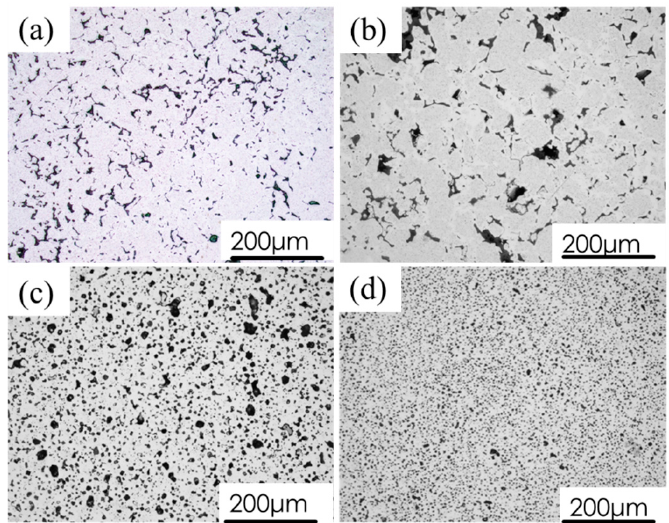
Figure 9. OM micrographs of as-sintered HEA NiMnFeCu. ( a ) At 1000 ◦ C for 1 h (S1), ( b ) at 1000 ◦ C for 2 h (S2), ( c ) at 1050 ◦ C for 1 h (S3), ( d ) at 1050 ◦ C for 2 h (S4). The microstructures of S1–S3 had many pores present, and the relative density for those three samples are much lower than that of S4. For S1 and S2, the sintering temperature was relatively low (1000 ◦ C) compared to S3 (1050 ◦ C), the sintering time is 1 h for S1 and S3 and 2 h for S2 and S4. From the microstructure observation (Figure 7), limited densification takes place for the S1–S3 samples, and large densification happened for the S4